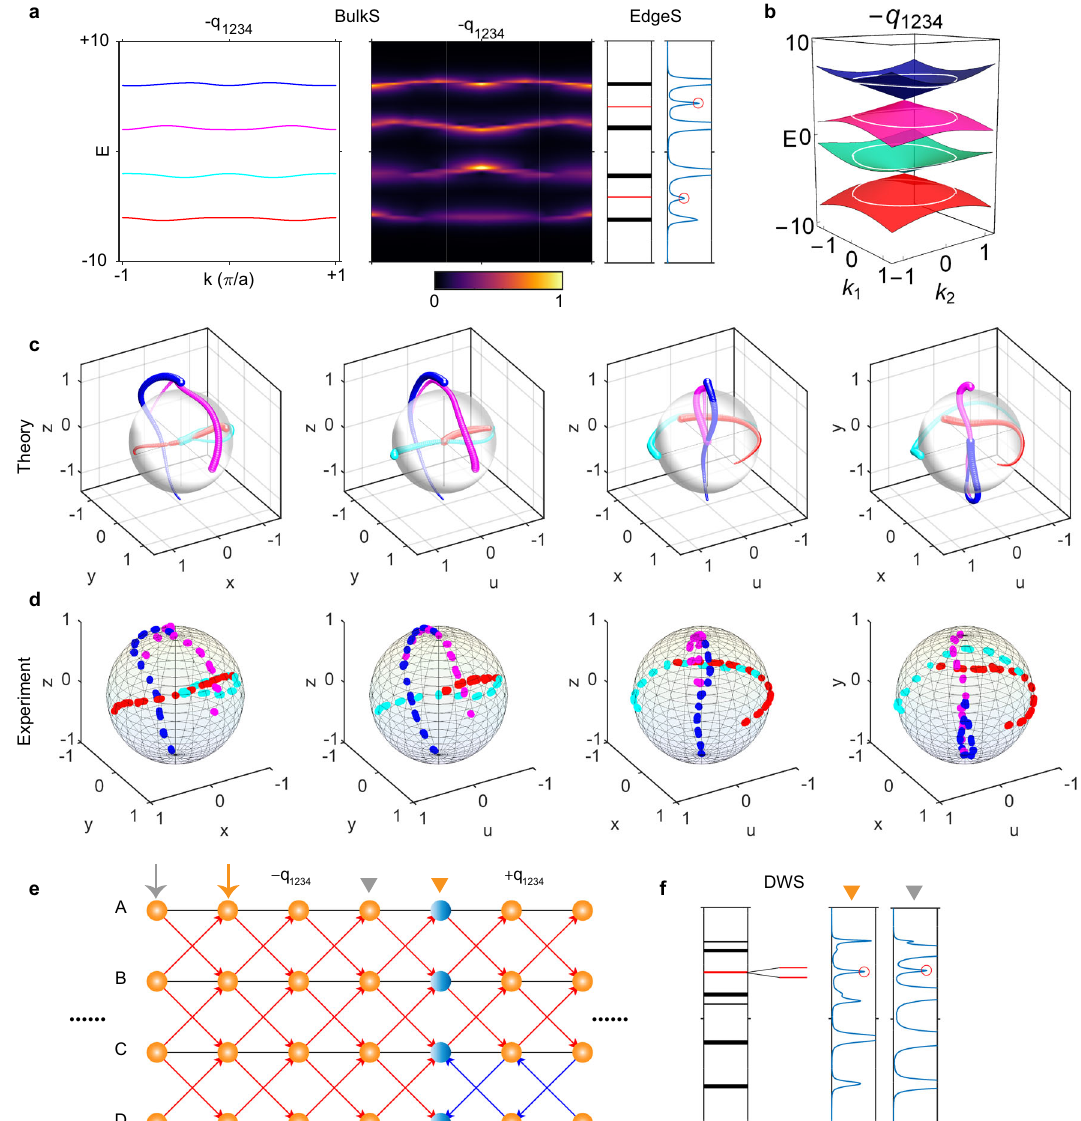
Fig. 4 Experimental observation of the charge − q 1234 and edge/domain-wall states. a The left panels show the numerically calculated and experimentally measured energy bands of bulk states (BulkS). The right panels display the energy spectra probed at the hard boundary, where the red lines and the peaks marked by red circles represent the simulation and experimental results of edge states (EdgeS), respectively. b Extended energy bands on a 2D plane; there is one linear Dirac cone between the fi rst/third and second/fourth bands. White circles indicate the 1D energy bands. c , d Calculated/measured orthographic projections of eigenstate trajectories. The colors of trajectories correspond to different bands in a . The direction of decreasing linewidth indicates k running from (cid:2) π to π . e Construction of the domain wall (marked by blue spheres) between charges (cid:2) q 1234 and þ q 1234 . The gray and yellow arrows/triangles denote two different excitation/probe positions. f Calculated and measured energy spectra for the two different pairs of excitation and probe positions. The two domain- wall states are nearly degenerate. The detailed distribution of edge/domain-wall states is shown in Supplementary Figs. 14 and